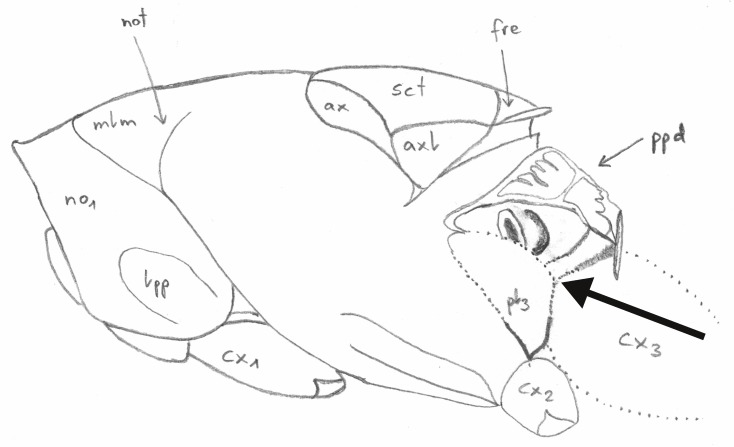
Inclination blunt.